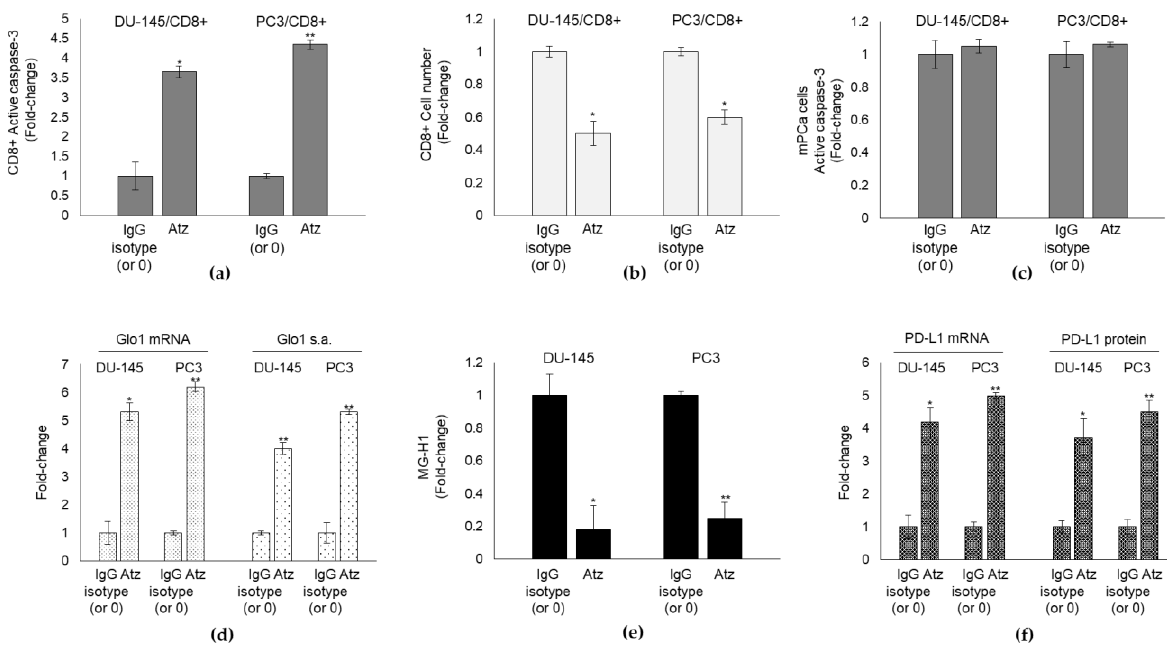
Figure 7. Glyoxalase 1 (Glo1)/MG-H1/PD-L1 axis contributes to the refractoriness of mPCa to the anti-PD-L1 therapy by